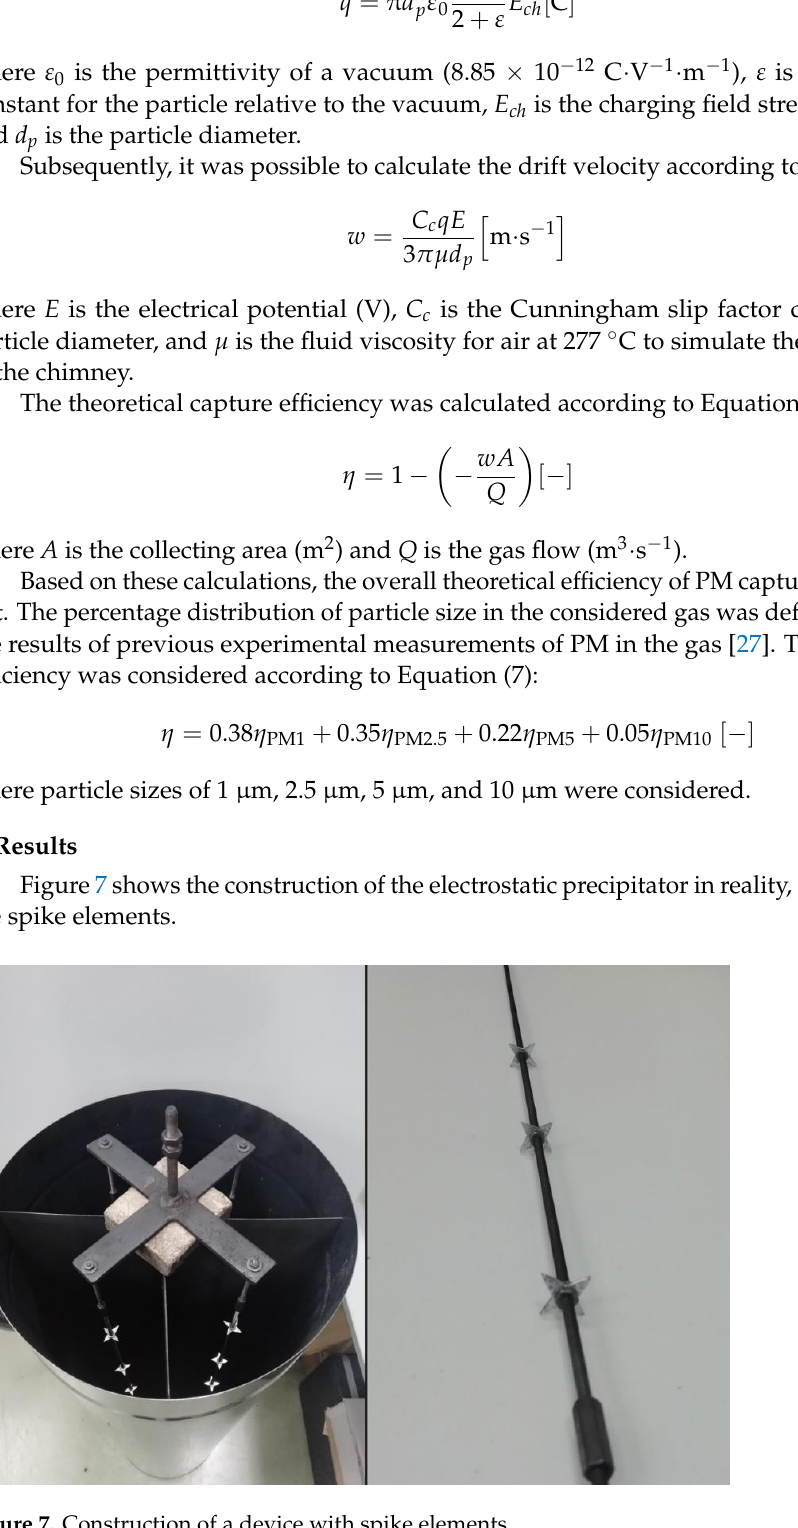
Figure 7. Construction of a device with spike elements.